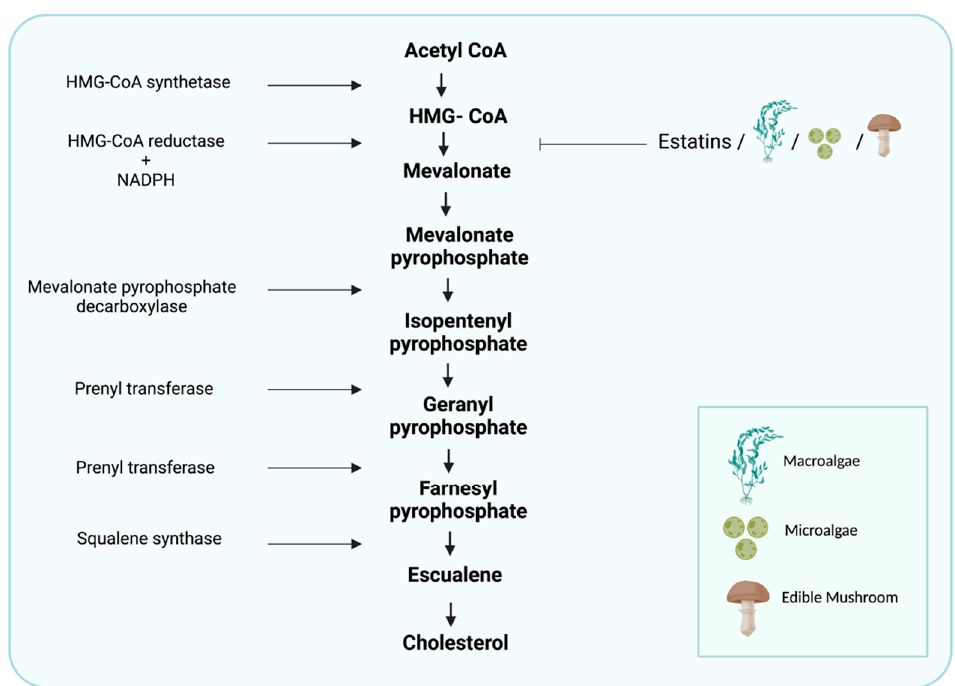
Figure 1. Cholesterol-synthesis pathway. The diagram includes the most relevant enzymes, the mediators of synthesis, and the point at which statins and algal- and edible mushroom-based phytochemicals interfere with the metabolism of HMG-CoA. (Created with BioRender.com). Cholesterol synthesis occurs in most cells but mainly in hepatocytes and enterocytes.